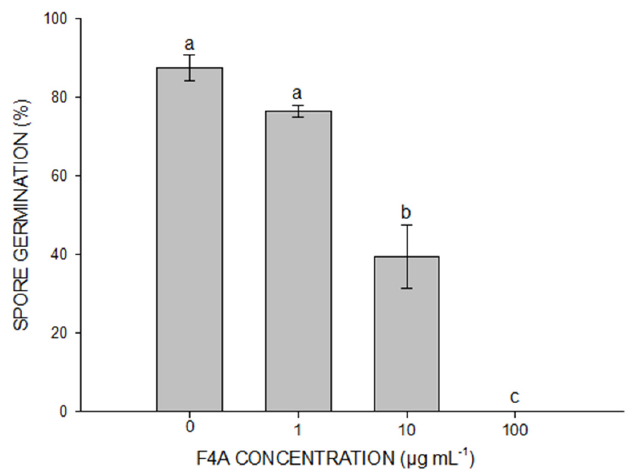
Figure 1. Quantification of P. pachyrhizi spore germination in water agar plus with different concentrations of the semi-purified fraction F4A. Different letters indicate significant differences by Tukey test at p < 0.05. Bars indicate standard deviation. CV = 8.6%.